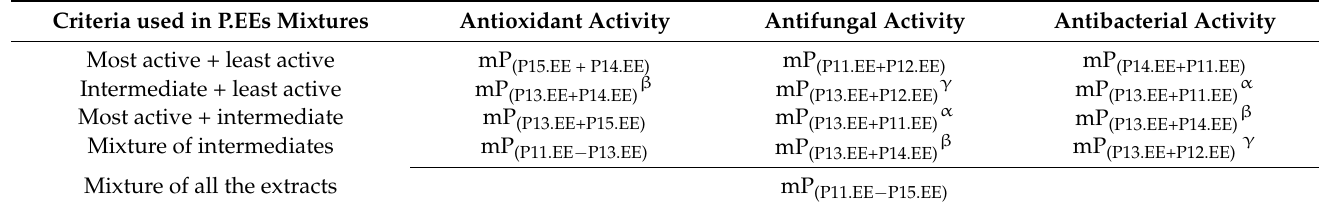
Table 9. Composition of blends of P.EEs based on five criteria and taking into account the classification of each P.EE regarding antioxidant, antifungal and antibacterial activities. Criteria used in P.EEs Mixtures Antioxidant Activity Antifungal Activity Antibacterial Activity